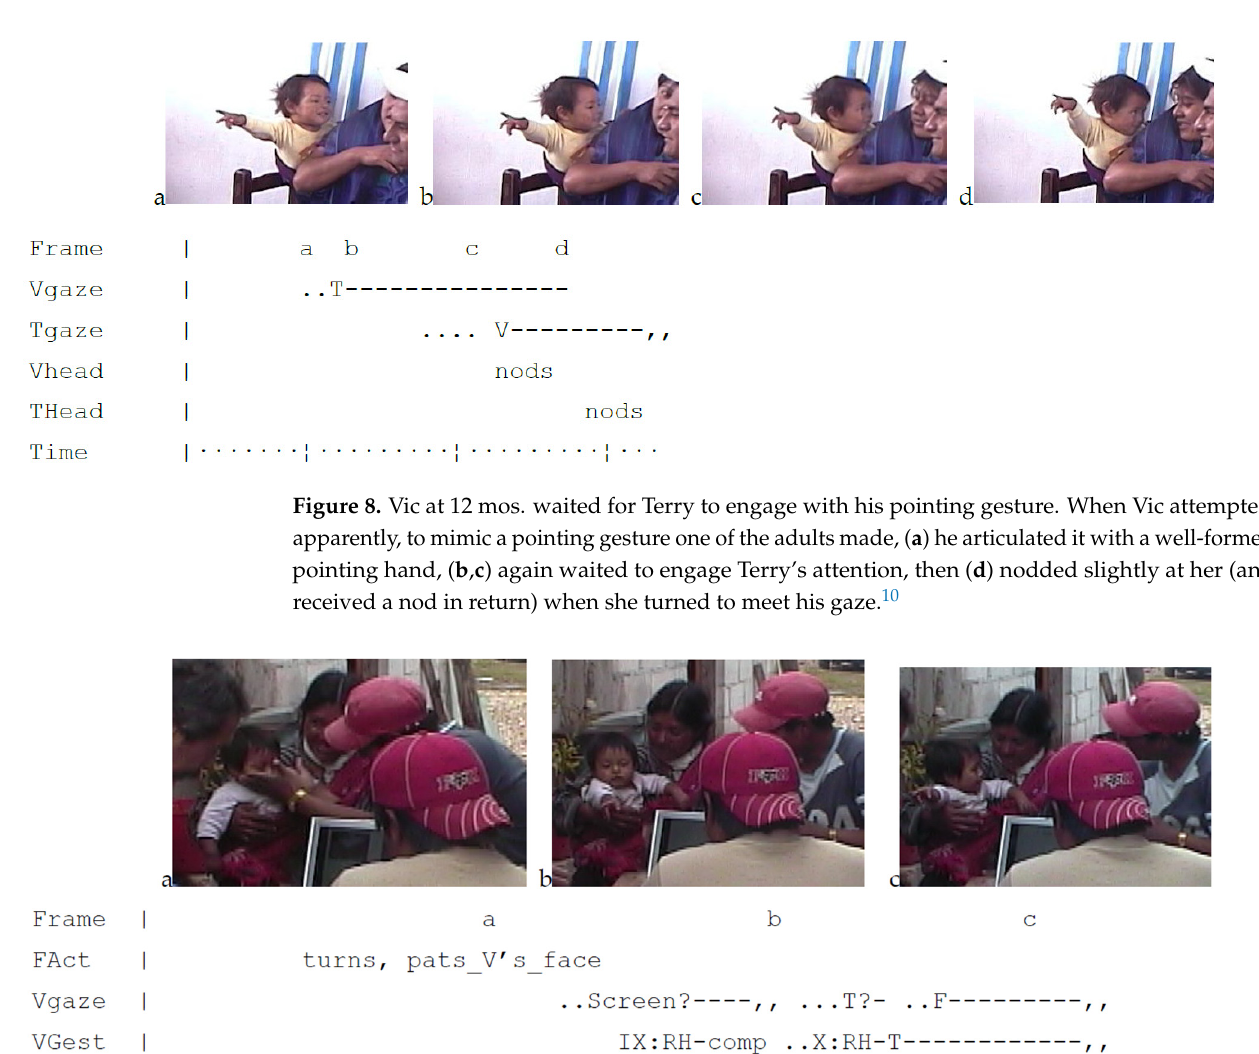
Figure 9. Vic at 12 mos. interacted with his uncle Frank. ( a ) Frank cupped the baby’s face and jok- ingly told him not to interfere with the work. (Frank signed WAIT to Vic, then pointed at the two signers watching the video and signed SHUSH.) In response, ( b ) Vic pointed at the two signers actively watching a video on the laptop, then ( c ) turned his gaze explicitly to Frank as if to direct his uncle’s attention to where he was pointing.